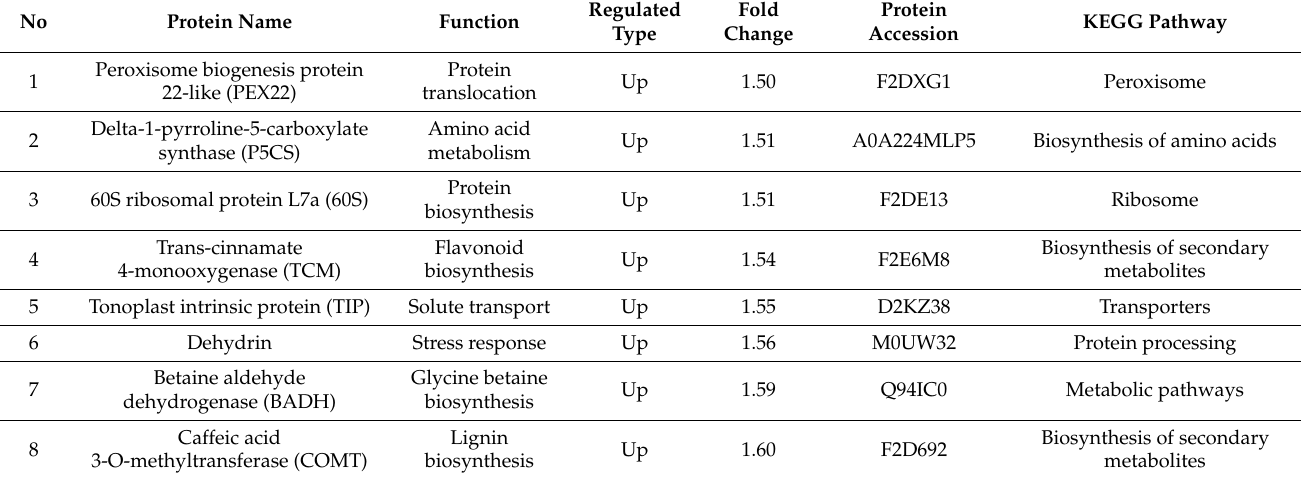
Table 2. Differentially abundant proteins (DAPs) in roots of barley under date palm waste com- post